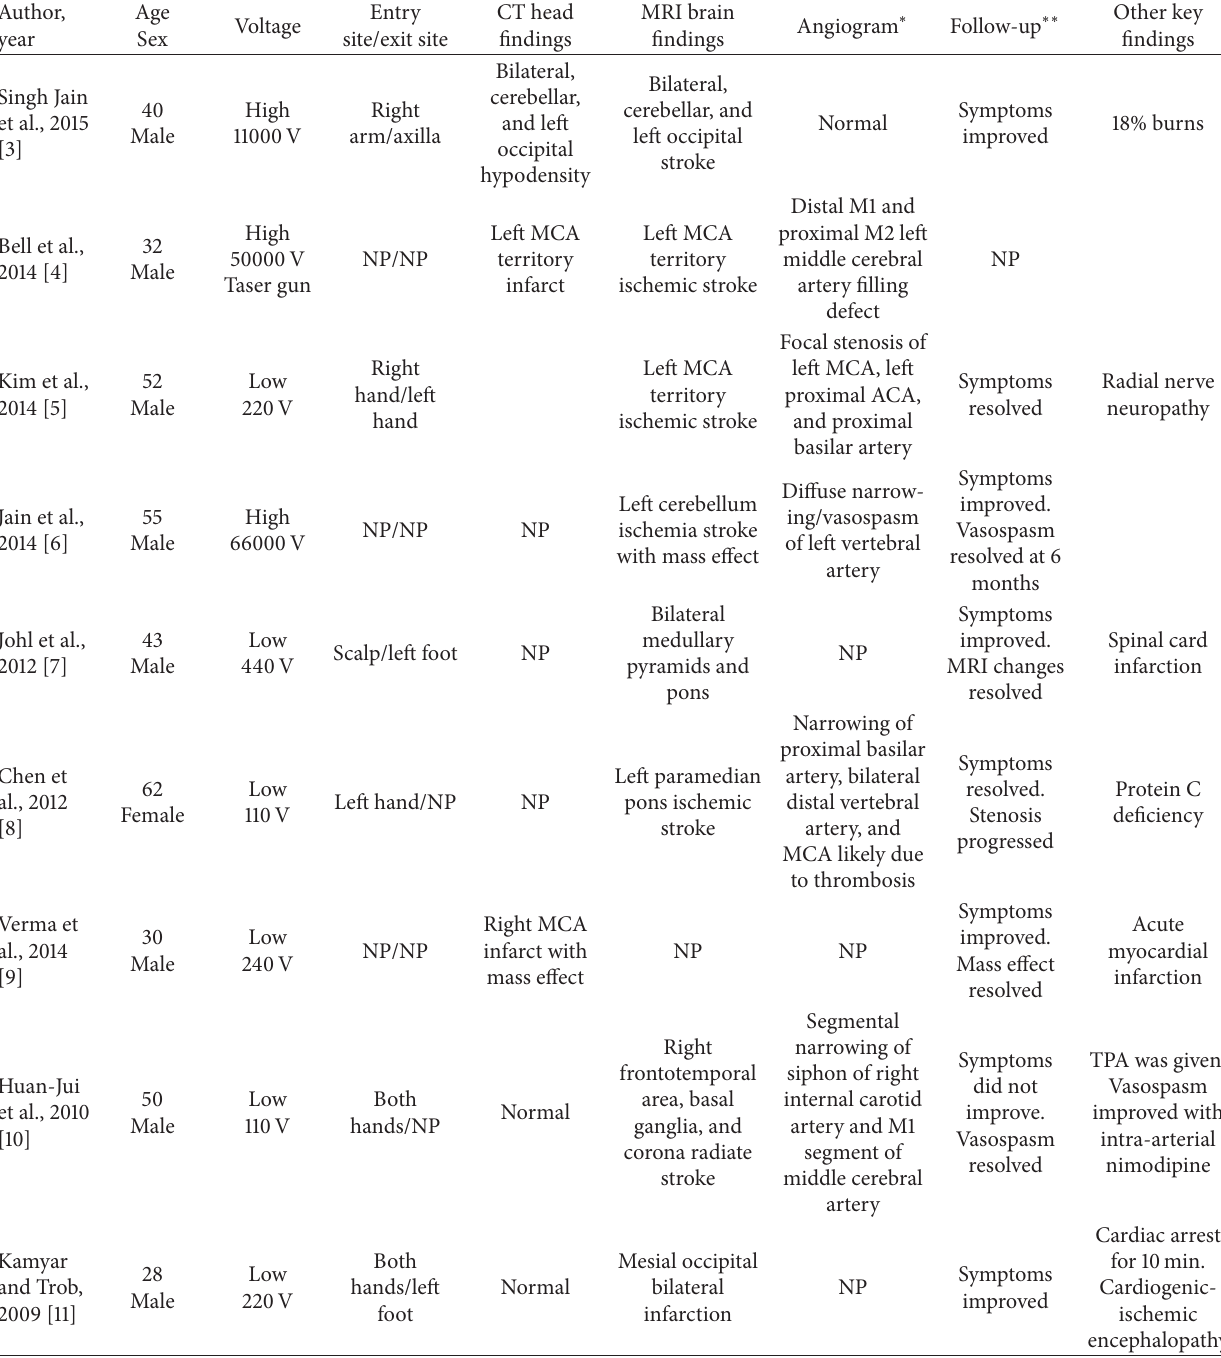
Table 2: Published case reports of acute stroke due to